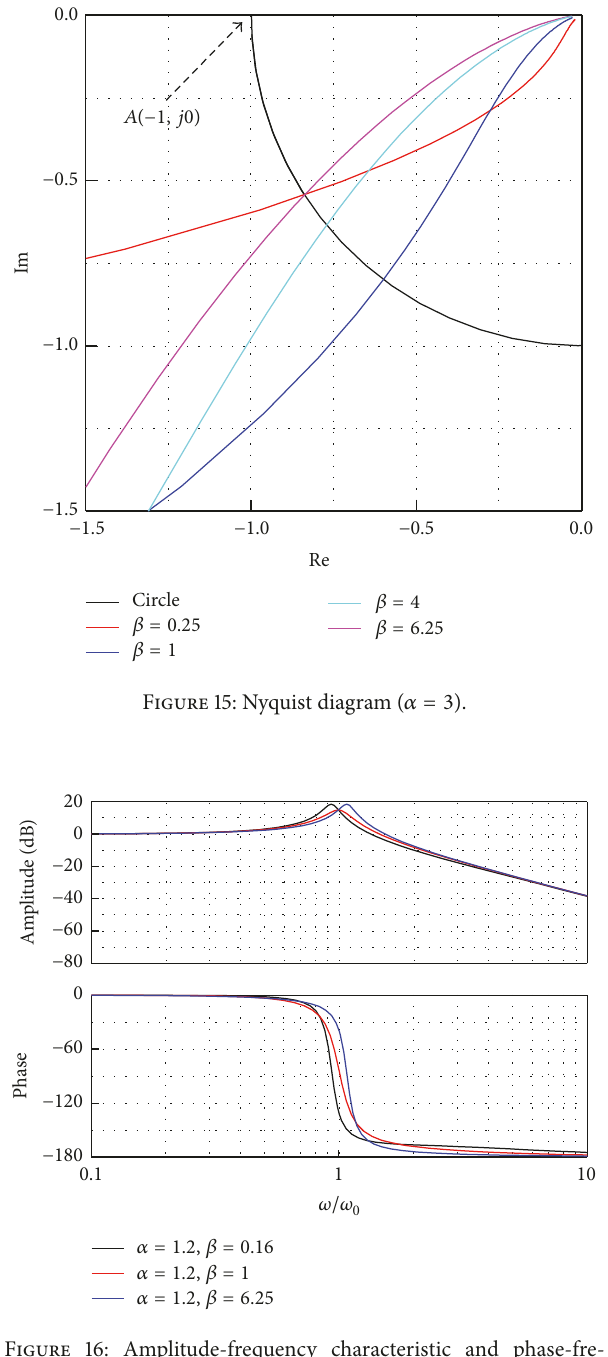
Figure 16: Amplitude-frequency characteristic and phase-fre- quency characteristic ( 𝛼 = 1.2, 𝛽 = 0.16, 1, 6.25 ).